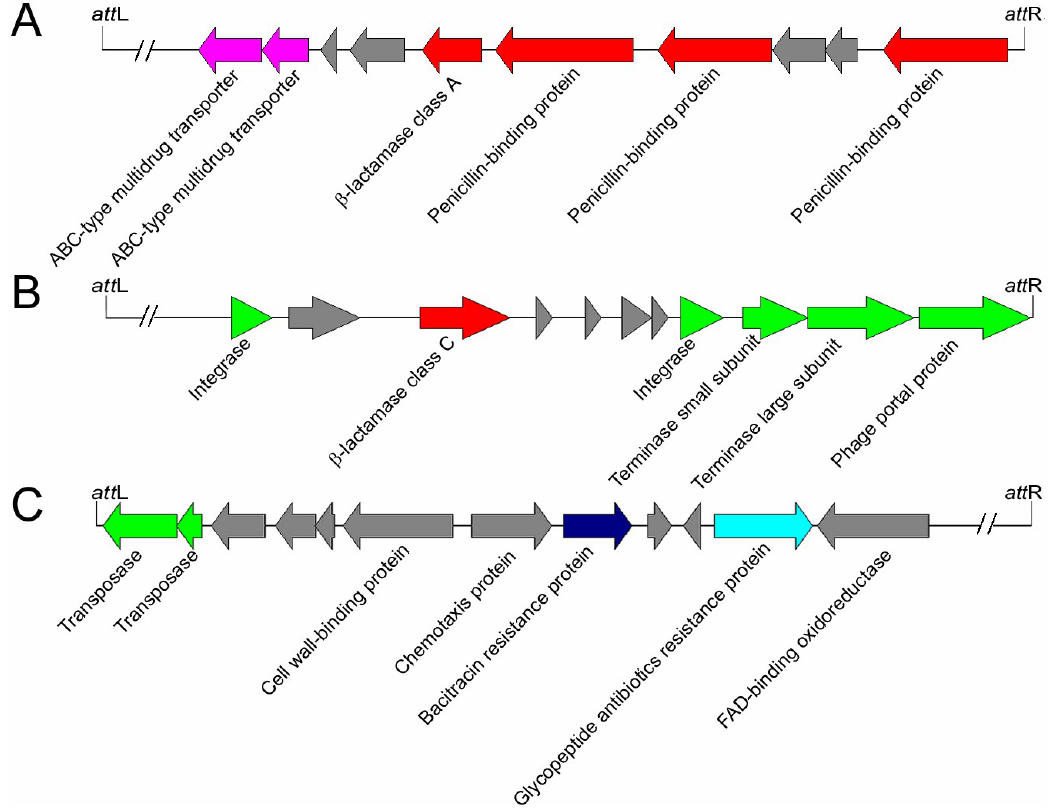
Figure 5. Schematic organization of Bt prophage regions containing antibiotic resistance genes. ( A ) The β-lactamase, ABC-type multidrug transporters, and penicillin-binding proteins encoded by HD-771 prophage-2. ( B ) The β-lactamase encoded by HD-521 prophage-1. ( C ) The bacitracin resistant proteins and glycopeptide antibiotic resistant protein encoded by prophage-12 in the Pasteur Institute Standard strain genome. The proteins associated with the life cycles of phages are indicated in green, and genes not associated with phage life cycles are shown in gray.